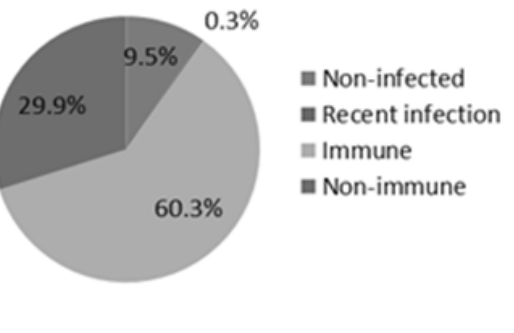
Figure 2. Sample classification during the study period.